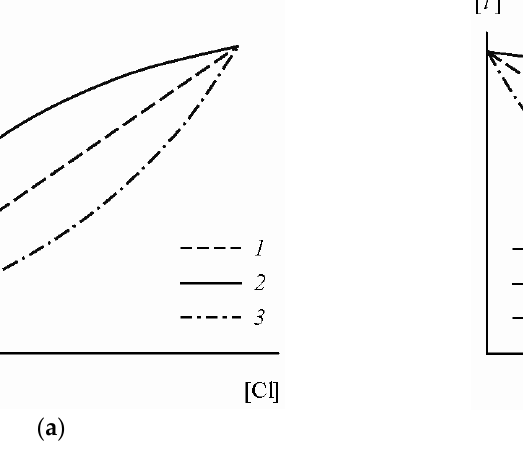
Figure 6. Relationships between the concentration of dissolved component i and chloride content by the conservative behavior ( 1 ) and availability of processes of additional input ( 2 ) or removal ( 3 ) of this component in the mixing zone of river and sea waters: ( a , b ) are cases when the concentration of component i in the river water is accordingly below or above that in the seawater.